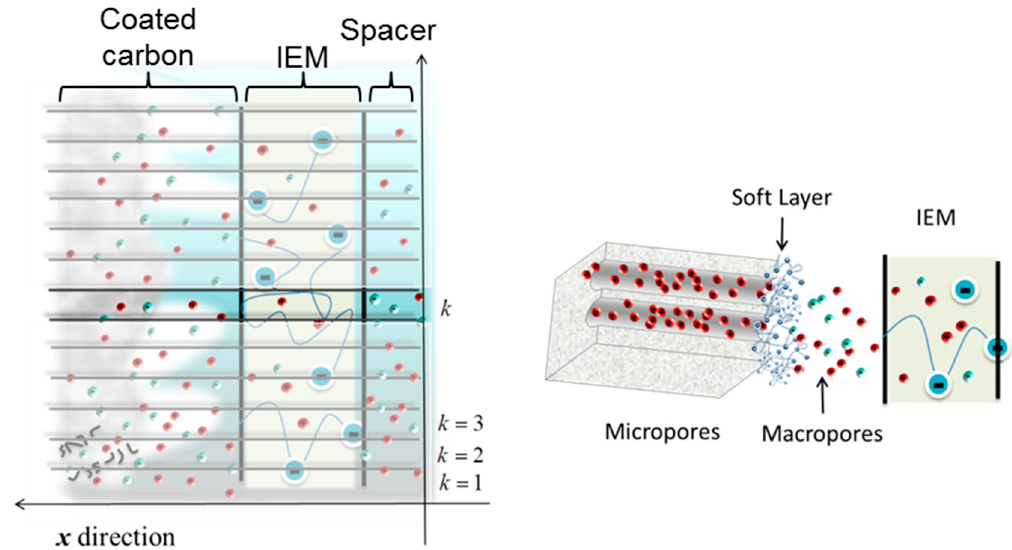
Figure 8. Sketch of half cell: One polyelectrolyte coated porous electrode in contact with a cation exchange membrane and the spacer channel. The flow of solution is from bottom to top.